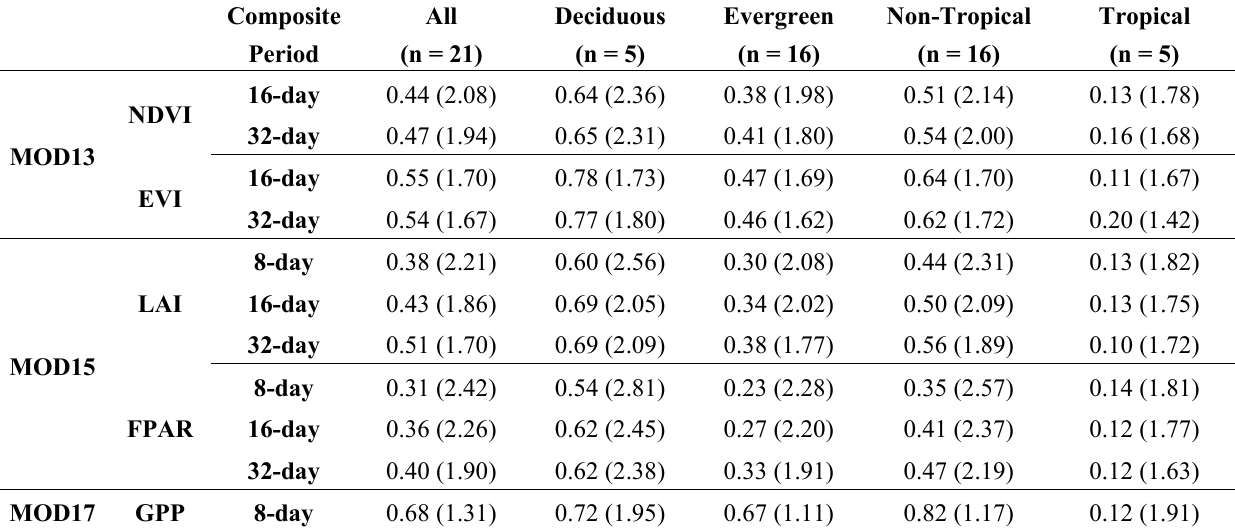
Table 3. Average R 2 between each MODIS product and flux tower GPP for each composite period. The values in parenthesis are root mean square error